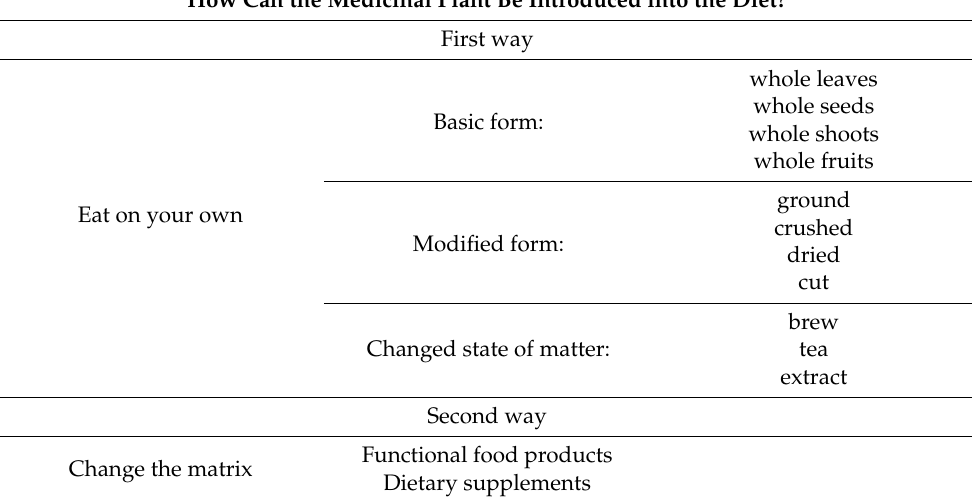
Table 1. Different possible ways of introducing medicinal plants into the diet. How Can the Medicinal Plant Be Introduced into the